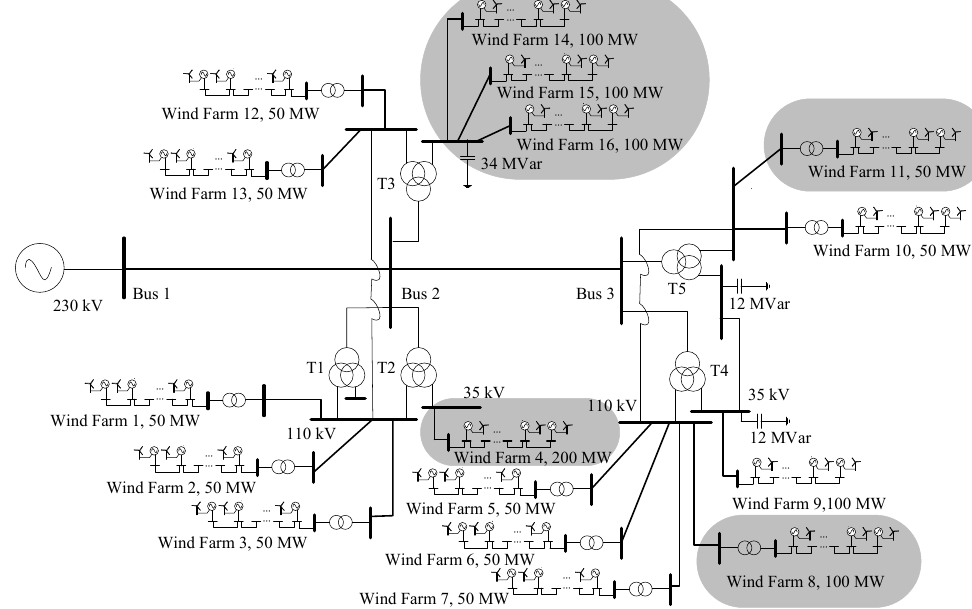
Figure 4. Schematic structure diagram of wind power bases with Type-IV wind generators. Table 2. Parameters of transformers and transmission lines.